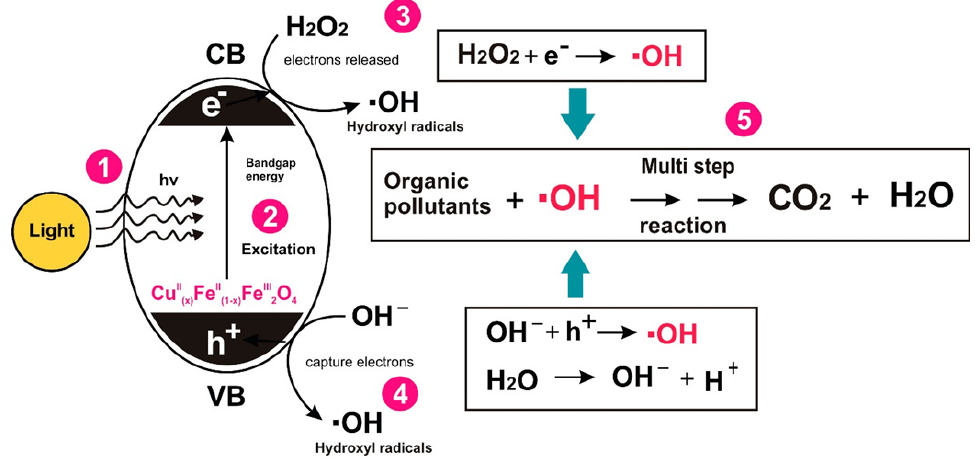
Figure 9. Schematic diagram for the degradation mechanism of organic pollutants in heterogeneous photo-Fenton photo-Fenton system.